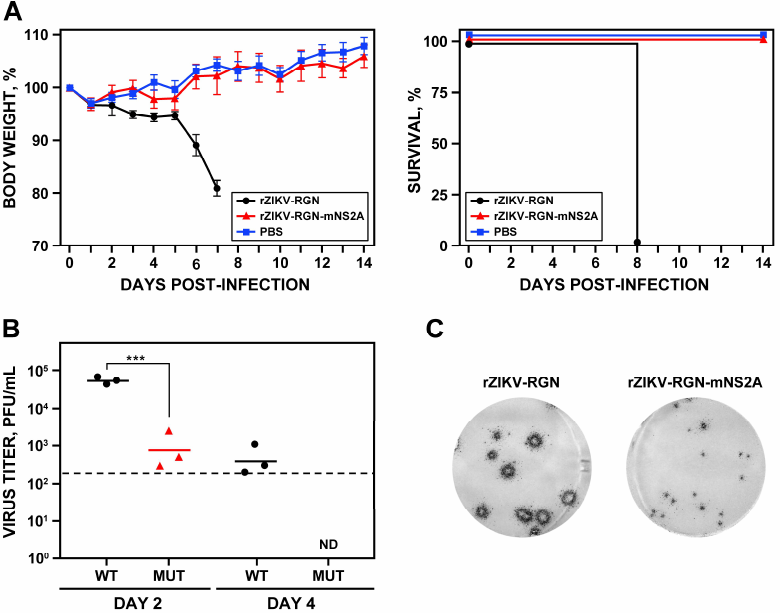
Figure 6. Pathogenesis of rZIKV-RGN-mNS2A in A129 mice. ( A ) Weight loss and mortality. Female 4-to-6-week-old A129 mice (five mice per group) were mock-infected (PBS) or infected s.c. in the footpad with 10 5 PFU of rZIKV-RGN or rZIKV-RGN-mNS2A, and body weight loss (expressed as the percentage of starting weight, left panel) and survival (right panel) were monitored daily during 14 days. Mice that lost more than 20% of their initial body weight or presented hind limb paralysis were humanely euthanized. Error bars represent standard deviations of the mean for each group of mice. ( B ) Viral titers in mice sera. Female 4-to-6-week-old A129 mice (six mice per group) were infected with 10 5 PFU of rZIKV-RGN (WT) or rZIKV-RGN-mNS2A (MUT) as described above, and viral titers in sera were determined at days two and four after infection (three animals per time point) by plaque assay and immunostaining using the pan-flavivirus E protein mAb 4G2. Symbols represent data from individual mice and bars the geometric means of viral titers. Asterisks indicate that the differences between rZIKV-RGN and rZIKV-RGN-mNS2A are statistically significant when data are compared using the unpaired t test (***, P < 0.001). ND: virus not detected. The detection limit of the assay (200 PFU/mL) is indicate as a dashed line. ( C ) Plaque phenotype. Vero cells at 90% confluence (6-well plate format) were infected with 25 PFU of rZIKV-RGN (left) or rZIKV-RGN-mNS2A (right) recovered from infected mice at day two post-infection and the plaque size evaluated by plaque assay and immunostaining using the pan-flavivirus E protein mAb 4G2.